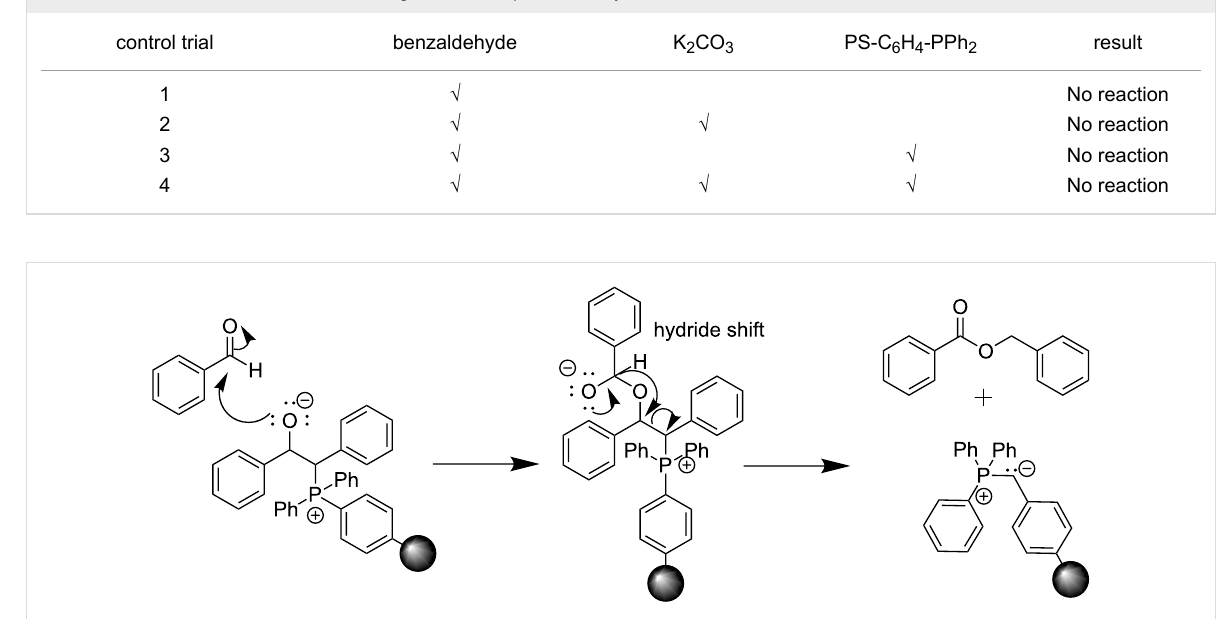
Table 2: Control reactions to determine the origin of the side product benzyl